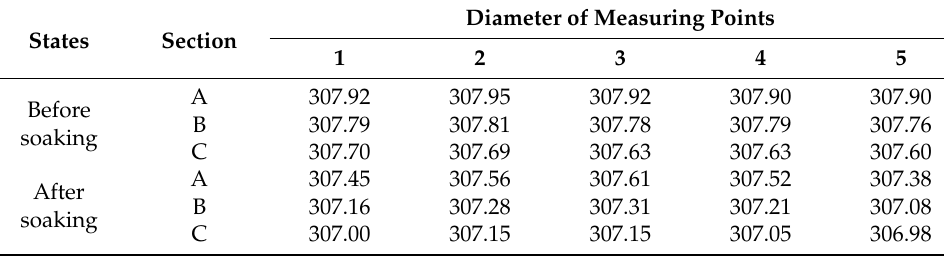
Table 2. Bearing diameter before and after